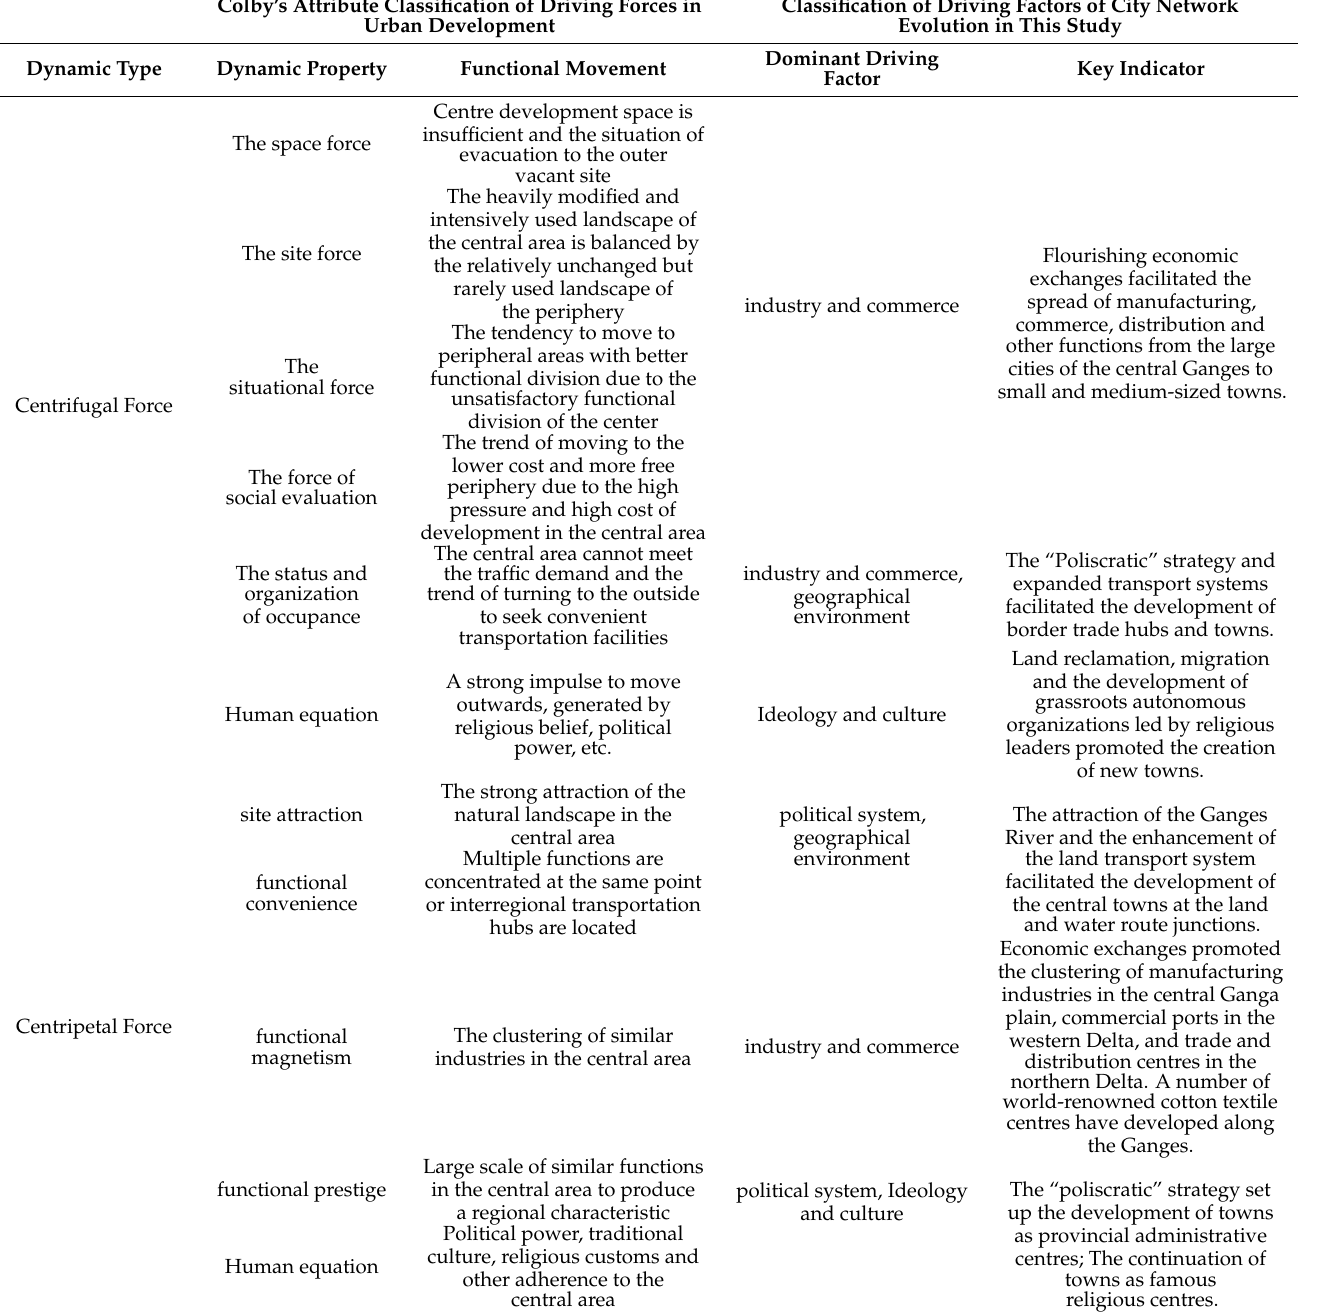
Table 1. Classification of Driving Factors for City Network